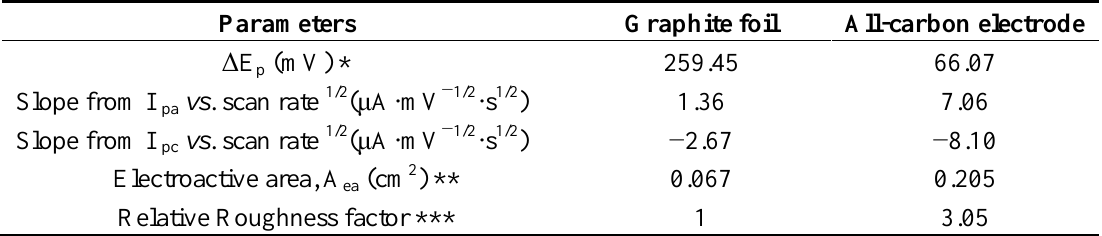
Table 1. Electrochemical characterizations of graphite foil and all-carbon electrode after 250th bending which are calculated from cyclic voltammograms in the scan rate